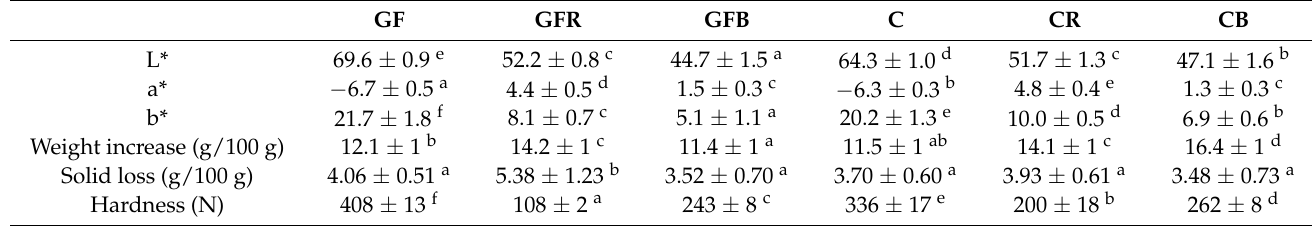
Table 3. Technological characterization of cooked